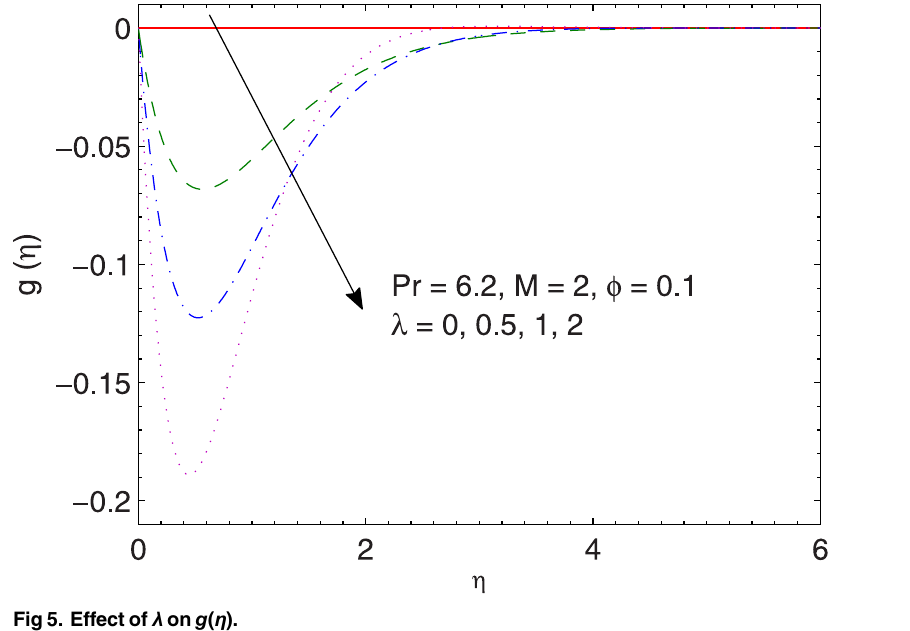
Fig 4. Effect of λ on f 0 ( η ). doi:10.1371/journal.pone.0149304.g004 In Figs 6 and 7 we plot the skin friction coefficients Re volume fraction ϕ for different values of λ . The values of skin friction coef fi cients Re 1 = 2 C and Re are negative since the fl uid applies stress on the stretching wall (that causes the y fy fl ow). Clearly the magnitudes of Re is attributed to the fact that transverse magnetic fi eld has a tendency to create a drag (known as